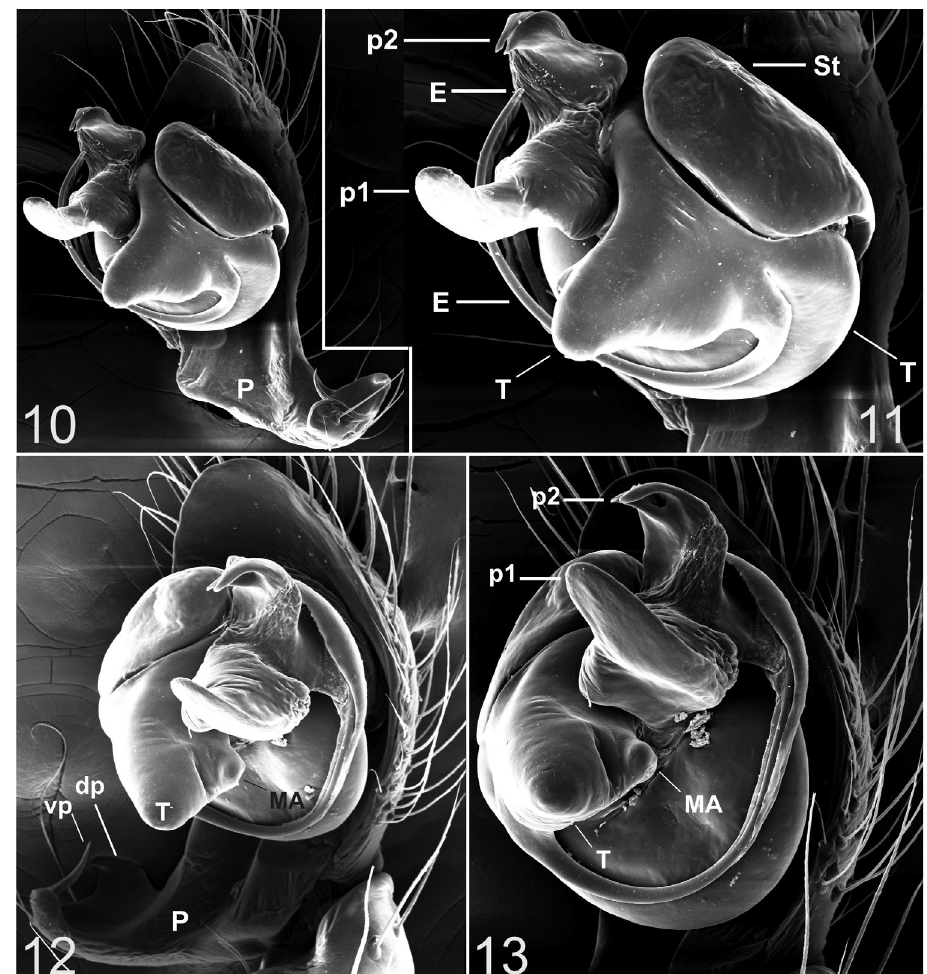
Figures 10–13. Typhlonesticus gocmeni sp. n. male palp. 10 nearly retrolateral view 11 ditto 12 nearly ventral view 13 ventral view. Abbreviations: E = embolus, T = tegulum, St = subtegulum, MA = median apophysis, p1 = process 1 of TTA, p2 = process 2 of TTA, P = paracymbium, vp = ventral process of paracymbium, dp = dorsal process of